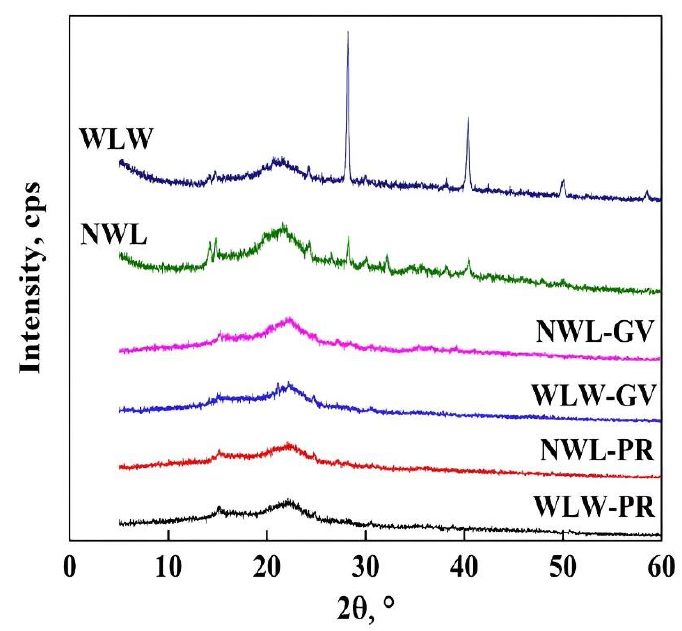
Figure 9. XRD patterns of WL with different pretreatments.